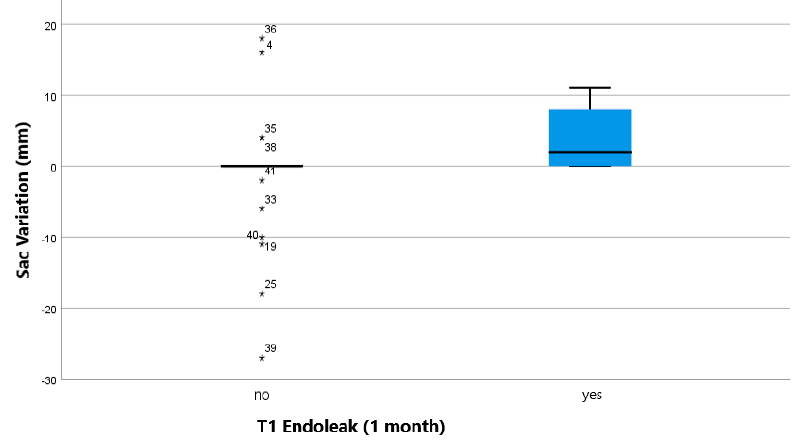
Figure 5. Boxplot showing relationship of endoleak occurrence at 1 month and aneurysmal sac var-